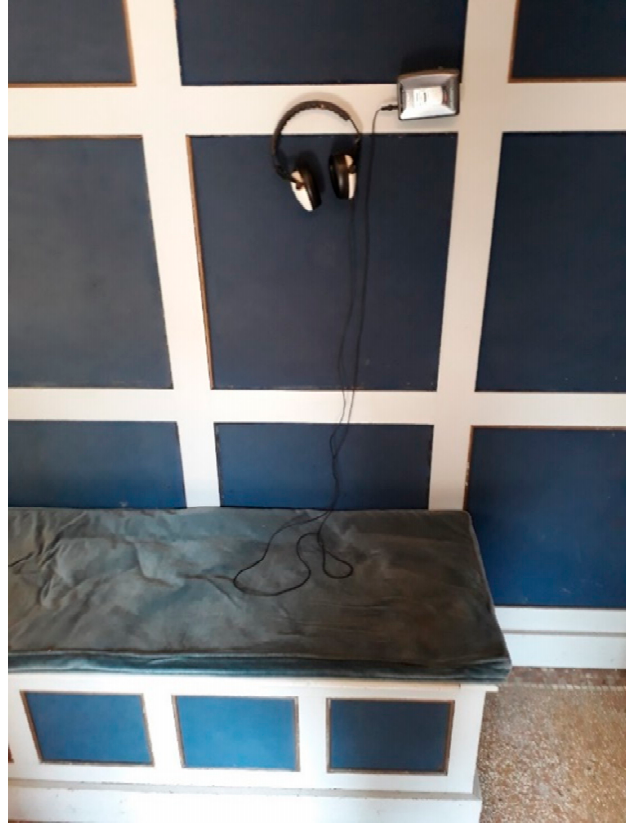
Figure 2. Installation at the Parcours d’artistes de Cointe, Liege, 20 May 2018 © Elsa